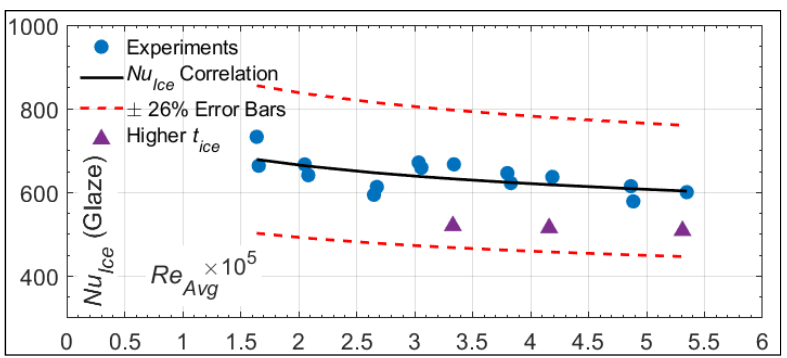
Figure 22. Comparison of Correlation Predictions versus Experimental Measurements of Nu Ice for the De-Icing Tests with Glaze Ice.